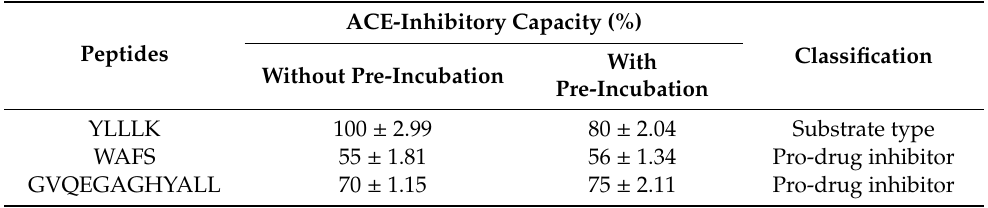
Table 3. ACE-inhibitory capacities (%) of peptides with and without pre-incubation with